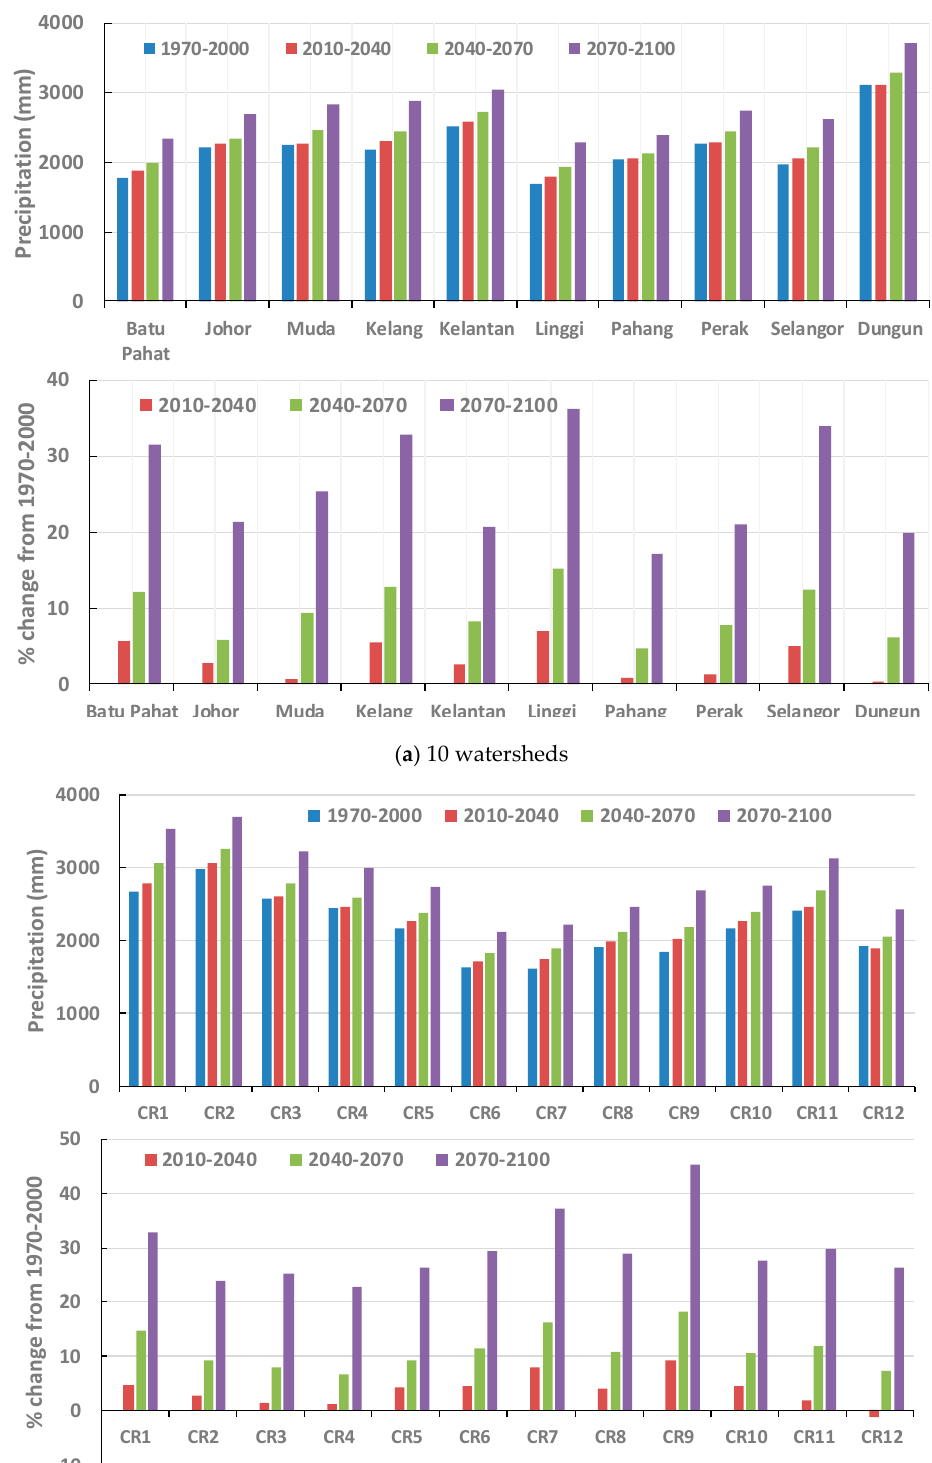
Figure 6. 30-year mean of the basin-average annual precipitation in Peninsular Malaysia during the historical period, and through the 21st century. The percent changes are provided from the historical 1970–2000 period. ( a ) 10 watersheds; ( b ) 12 Coastal Regions (CRs).